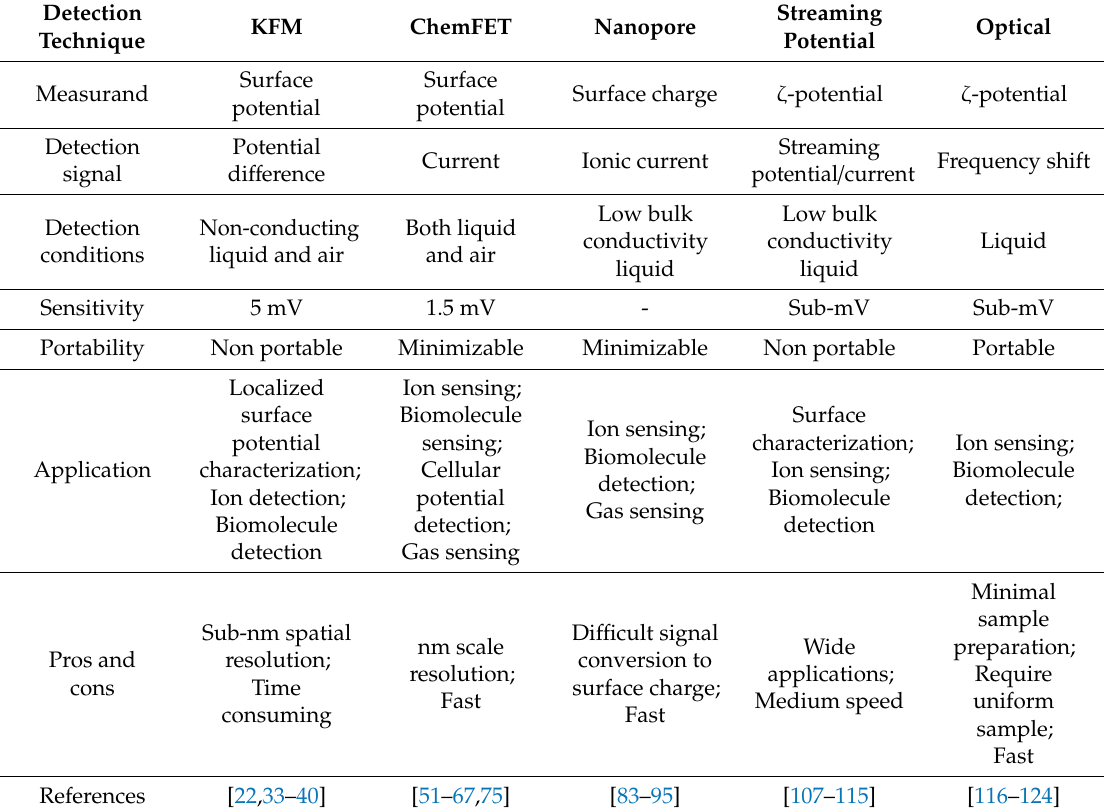
Table 1. Comparison of surface potential / charge detection